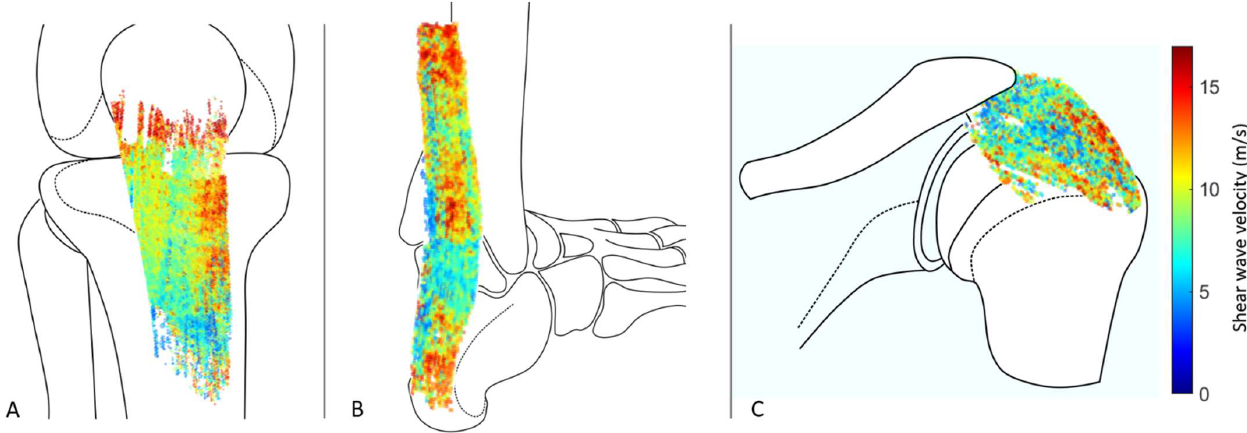
Figure 5. Heatmap visualization of 3D SWVM of the patellar ( A ), Achilles ( B ), and supraspinatus ( C ) tendon after manual segmentation. Artistic representations of the bony structures are added for more clarity.